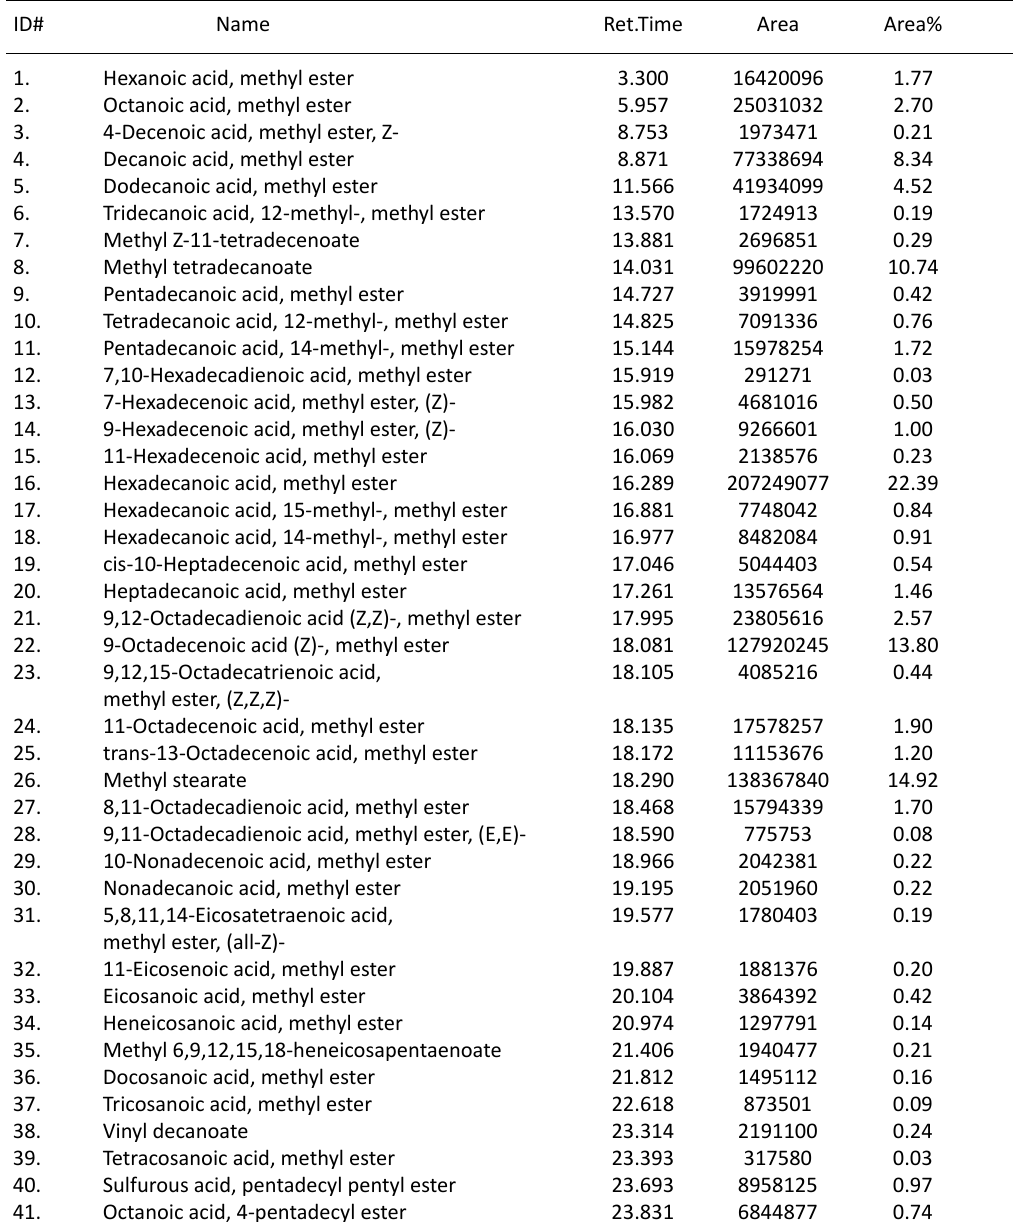
Table 1. Chemical constituents of goat margarine identified by GC-MS ID# Name